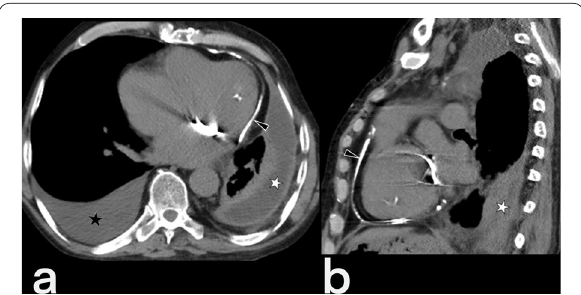
Fig. 19 Transverse ( a ) and sagittal reformatted ( b ) CT images without intravenous contrast of a 55-year-old male. Pericardial thickening with linear calcification (arrowheads), right-sided pleural effusion (black asterisk), and infected fluid collection (white asterisk) in the left pleural cavity are seen. Mediastinal and pericardial tuberculous